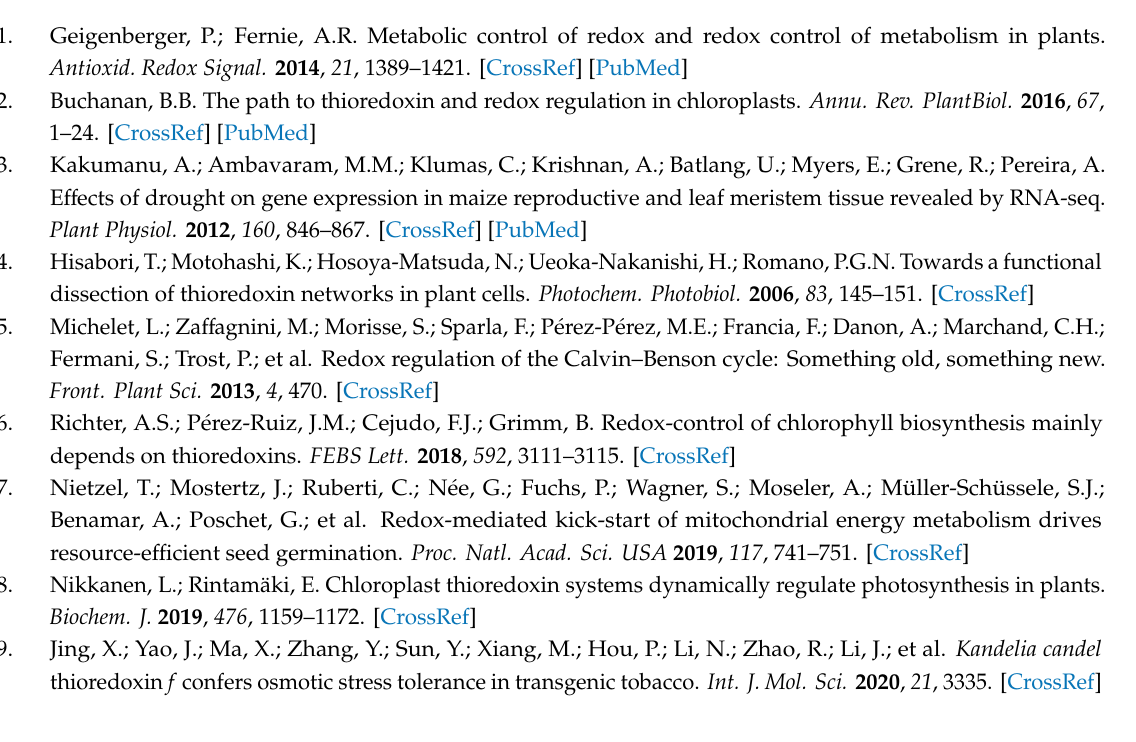
Table S1: Factorial ANOVA results of the tested parameters (maize genotype, aphid species, number of aphids, infestation time) and the interactions on relative expression of the examined thioredoxins-encoding genes ( Trx-f , Trx-h , Trx-m , Trx-x , Trx-lp4B ) in the maize seedlings; Table S2: Factorial ANOVA results of the tested parameters (maize genotype, aphid species, number of aphids, infestation time) and the interactions on the relative expression of the thioredoxin reductase genes ( Ftr1 , Trxr2 ), and the total activity of thioredoxin reductase (TrxR) in the maize seedlings; Table S3: List of primers and TaqMan fluorescent probe for real-time qRT-PCR quantification of Ftr1 maize